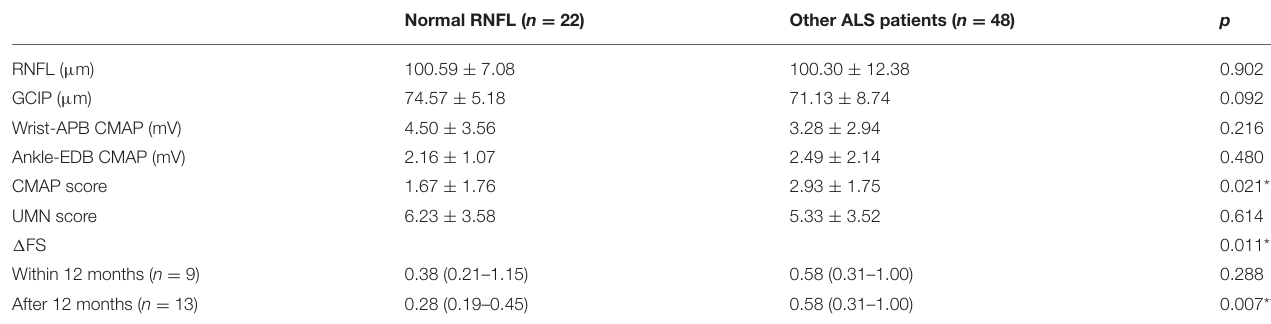
TABLE 4 | Comparison of RNFL, GCIP and disease parameters between patients with normal RNFL and the other ALS patients. Normal RNFL ( n = 22) Other ALS patients ( n = 48)